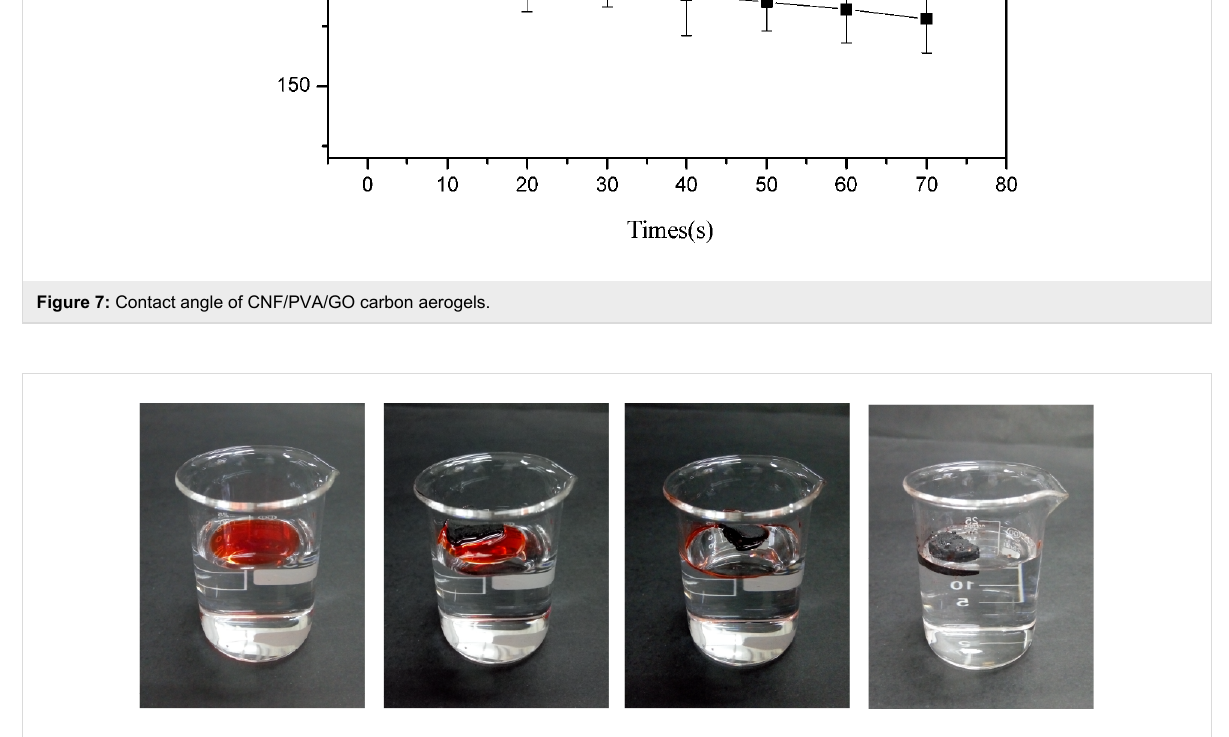
Figure 8: Removal of soybean oil (dyed with Sudan red) from the water surface using carbon aerogel.